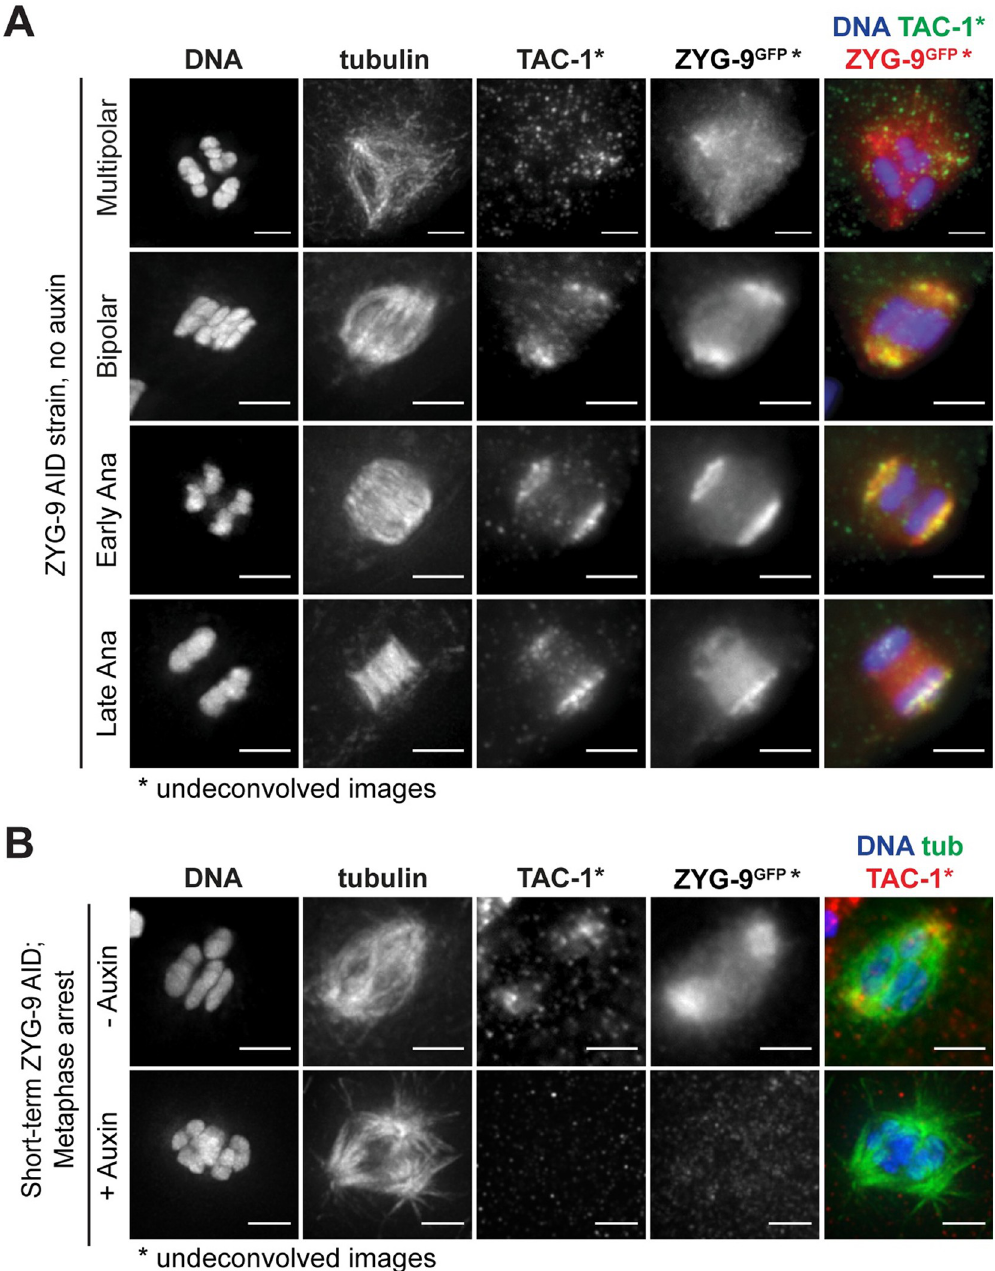
Fig 4. TAC-1 and ZYG-9 are interdependent for localization to acentrosomal poles. (A) IF imaging of oocyte spindles; shown are DNA (blue), TAC-1 (green), ZYG-9 (stained with a GFP antibody; red), and tubulin (not shown in merge). Colocalization of TAC-1 and ZYG-9 is evident in metaphase and persists throughout anaphase (12/12 spindles). DNA and tubulin channels were deconvolved, while ZYG-9 and TAC-1 channels were not due to higher background staining of the TAC-1 antibody. Bars = 2.5 μ m. (B) IF imaging of oocyte spindles in the ZYG-9 AID strain in Metaphase I-arrest (emb-30 (RNAi)) conditions; shown are DNA (blue), tubulin (green), TAC-1 (red), and ZYG-9 (stained with a GFP antibody; not shown in merge). Short-term ZYG-9 depletion via addition of auxin disrupts localization of TAC-1 to acentrosomal poles (8/ 8 spindles). As in (A), ZYG-9 and TAC-1 channels were not deconvolved. Bars = 2.5 μ m.